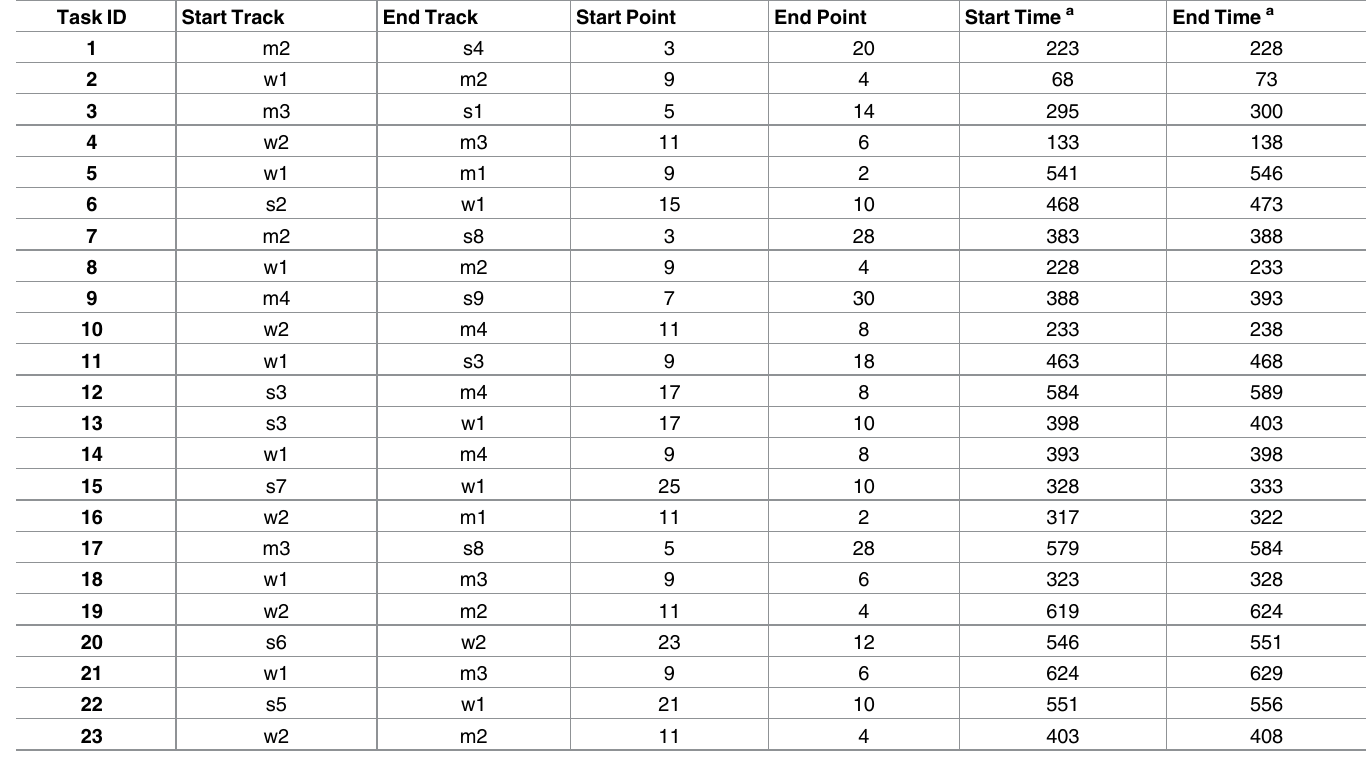
Table 2. Shunting tasks deriving from Fig